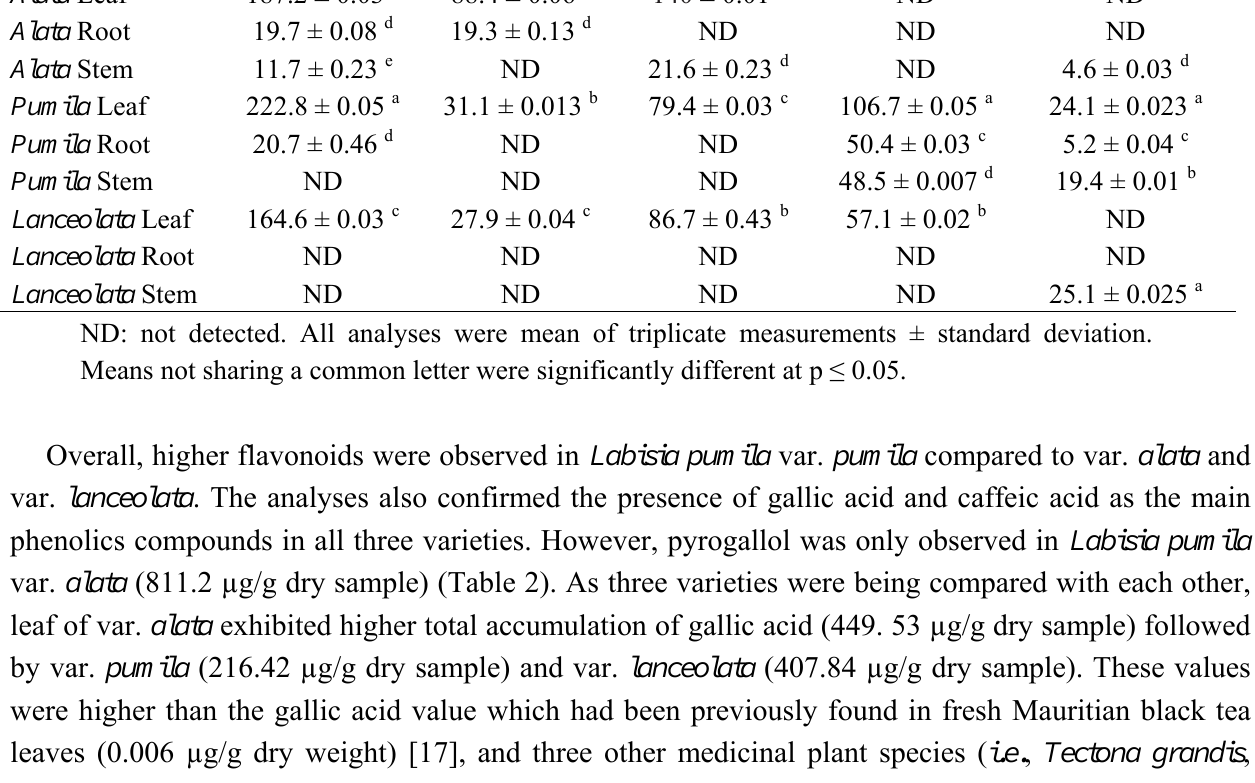
Table 1. Concentration of different flavonoid compounds from methanolic extract of leaf, stem and root of three varieties of Labisia pumila Benth.